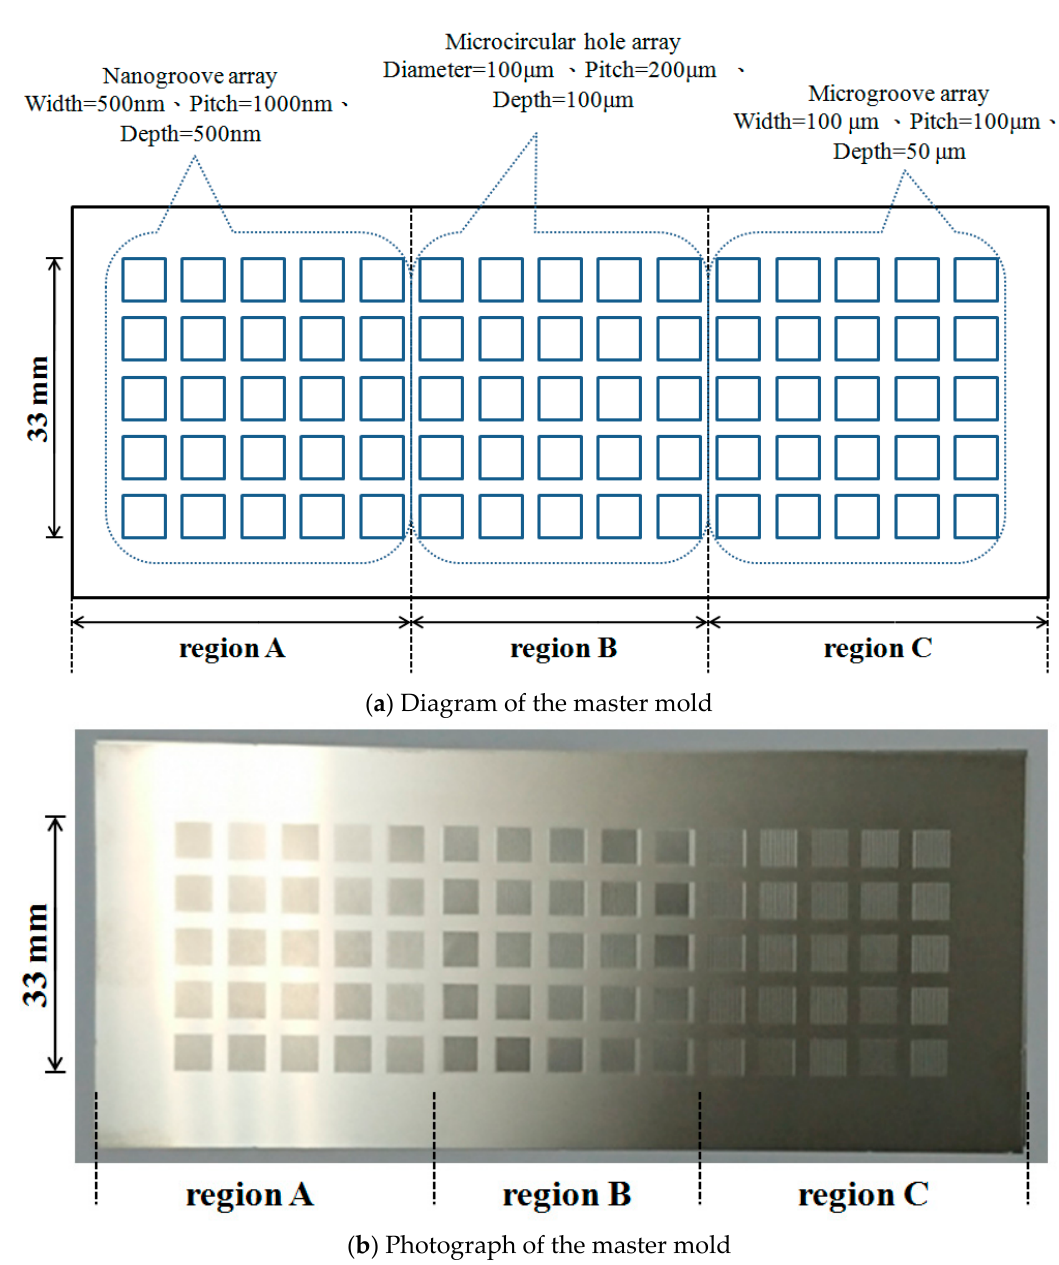
Figure 1. Diagram and photograph of the master mold with multiscale microstructures.